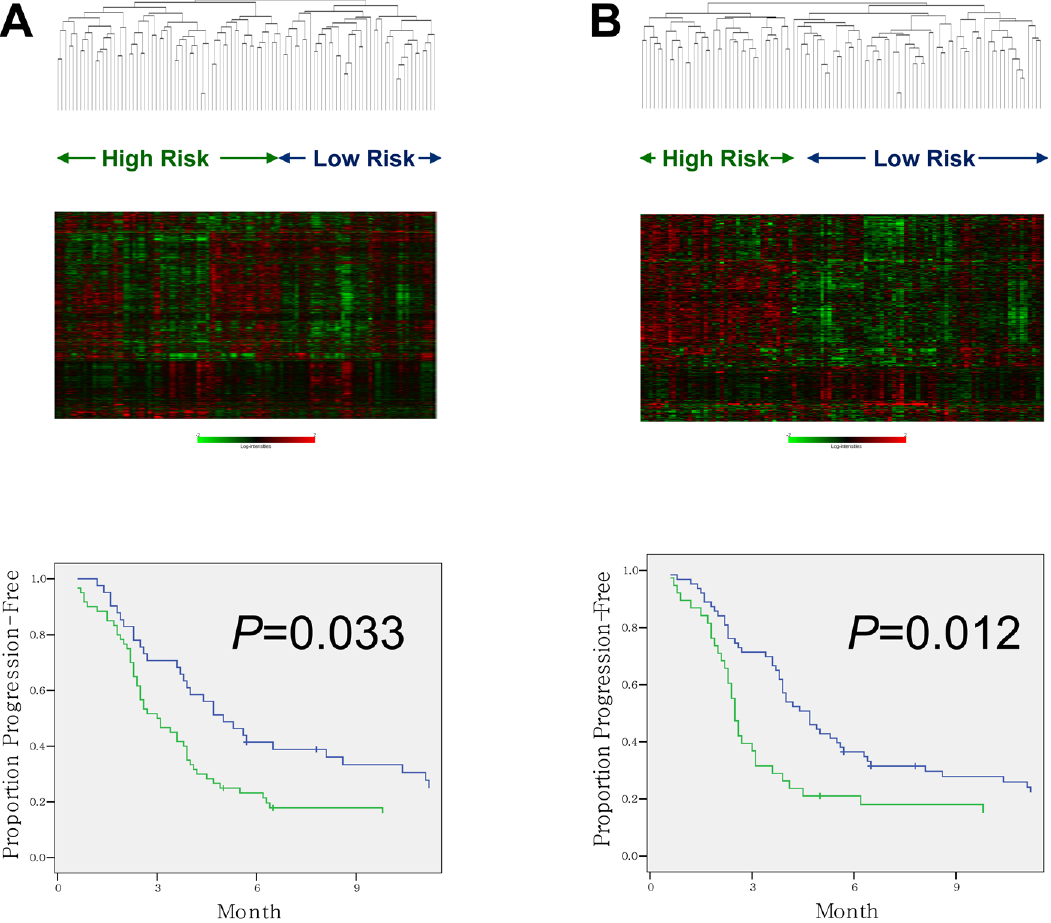
Figure 1. Hieraching clustering analyses of pretreatment samples using acquired resistance signatures. Hierarchical clustering dendrograms of pretreatment samples from a separate set of 101 gastric cancer patients, using genes differentially expressed between the pretreatment- and chemoresistant-states of 22 rebiopsied responders at various P cutoffs for feature selection. Kaplan-Meier plots for the time to progression (TTP) calculated for each of the two major clusters generated by each dendrogram are shown below. (A) Hierarchical clustering of 101 pretreatment samples using the 2,446–gene acquired resistance signature ( P for feature selection , 0.05). Heatmap generated using a log 2 - pseudocolor image with gene centering. Kaplan-Meier plots for TTP calculated for each of the two major clusters generated are shown below. Patients in high risk cluster (n=60, high expression of the genes upregulated at chemoresistant state ( upper ) had a significantly shorter TTP than patients in low risk cluster (n=41, low expression) (3.0 vs . 5.0 months; P =0.033). (B) Hierarchical clustering of the same 101 gastric cancer samples using the 633–gene acquired resistance signature ( P for feature selection , 0.01). Patients in high risk cluster (n=38, high expression of genes upregulated at chemoresistant state ( upper ) had a significantly shorter TTP than patients in low risk cluster (n=63, low expression) (2.5 vs . 4.7 months; P =0.012).